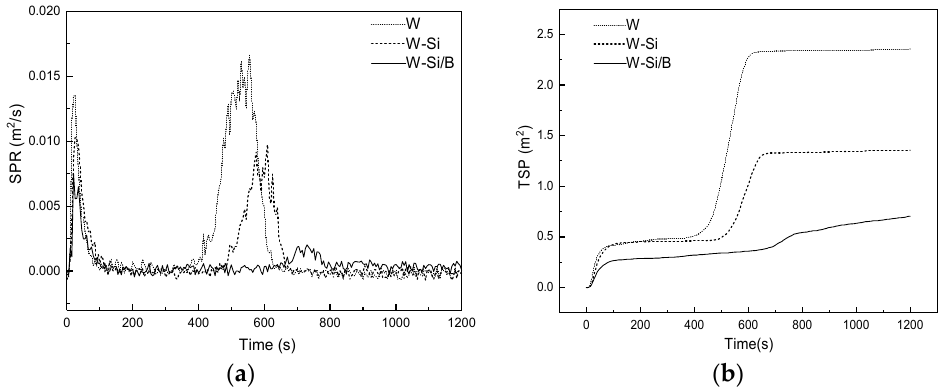
Figure 3. Changes in ( a ) smoke production rate (SPR) and ( b ) total smoke production (TSP) of wood.